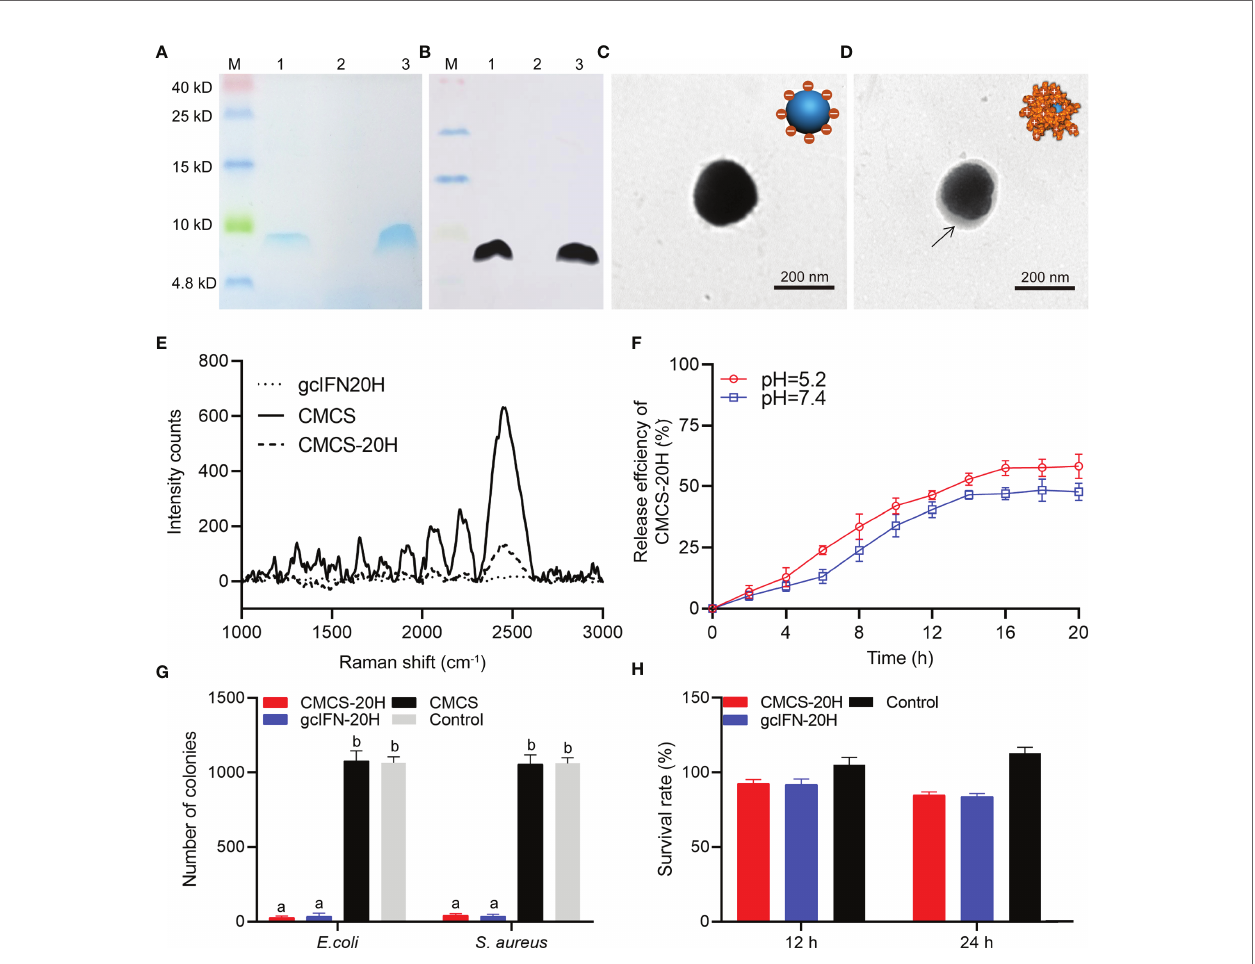
FIGURE 1 | Preparation, characterization, and bioactivity of CMCS-20H nanoparticles. (A) SDS-PAGE and (B) WB analyses of gcIFN-20H. Lane M: protein marker. Lane 1: the fermentation supernatant of gcIFN-20H. Lane 2: the fermentation supernatant of blank vector as negative control; Lane 3: puri fi ed gcIFN-20H. (C) Transmission electron micrograph of CMCS. (D) Transmission electron micrograph of a CMCS-20H. The black arrow indicates the position of gcIFN-20H. (E) Raman spectroscopy analysis. (F) In vitro release ef fi ciency of gcIFN-20H (plotted as a function of % cumulative release vs. time) from CMCS-20H in PBS buffer (pH = 5.2 and 7.4). (G) Antibacterial activity detection of CMCS-20H and gcIFN-20H. E. coli and S. aure us (1 × 10 6 CFU) were incubated with CMCS-20H, gcIFN-20H, and CMCS (20 m g/ml) for 2 h at 37°C, respectively. The equivalent volume of Tris was used as control. (H) Cytotoxicity of CMCS-20H and gcIFN-20H to CIK cells. CMCS-20H and gcIFN-20H ( fi nal concentration at 256 µg/ml) were respectively incubated with CIK cells for 24 h at 28°C. PBS was employed as control. Data are presented as means ± SD ( n = 3). Different lowercase letters in each group (a and b) denote signi fi cant variations suggested by the Kruskal-Wallis statistics followed by the Dunn ’ s multiple comparison (p <